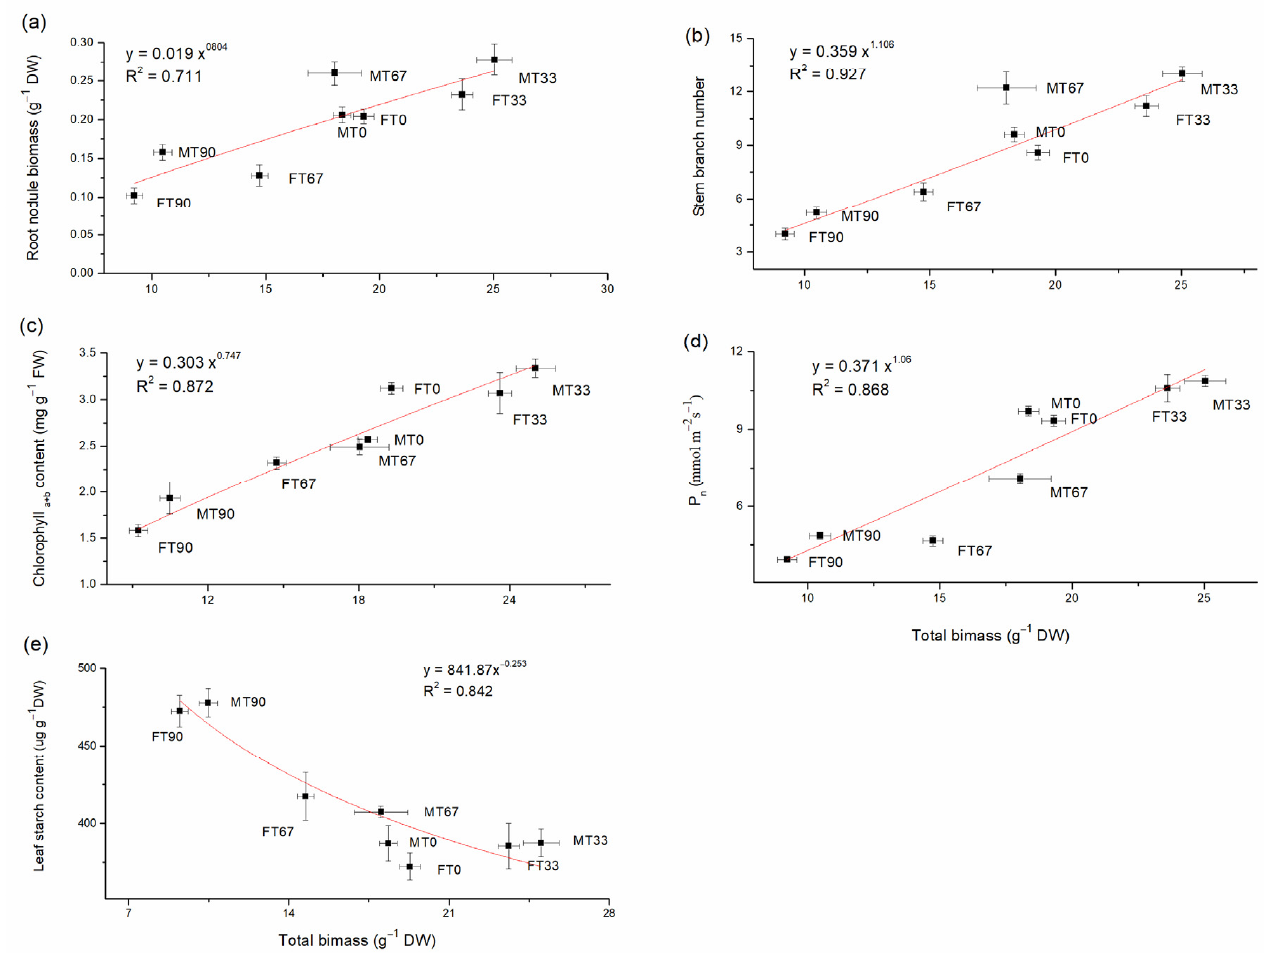
Figure 5. Correlation analysis and non-linear model regression between total biomass (mean ± SE, n = 5) and ( a ) root nodule biomass, ( b ) stem branch number, ( c ) chlorophyll a+b content ( d ) net photosynthetic rate (P n ) and ( e ) leaf starch content of two sexes of H. rhamnoides under different sand burial treatments. FT0 and MT0, female and male unburied control treatment, respectively; FT33 and MT33, females and males, respectively, under 33% sand burial treatment; FT67 and MT67, females and males, respectively, under 67% sand burial treatment; FT90 and MT90, females and males, respectively, under 90% sand burial treatment.